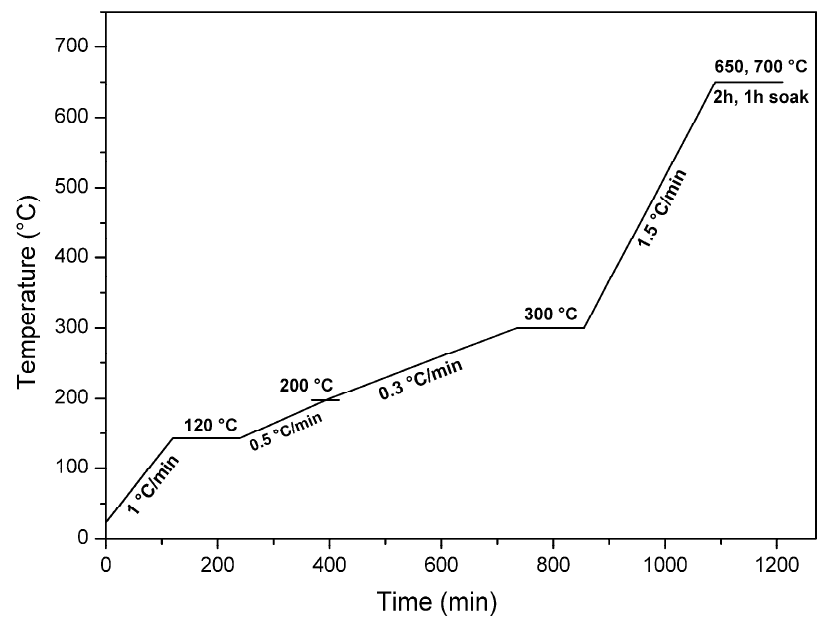
Figure 6. Carbonization protocol used by MemfoACT AS.